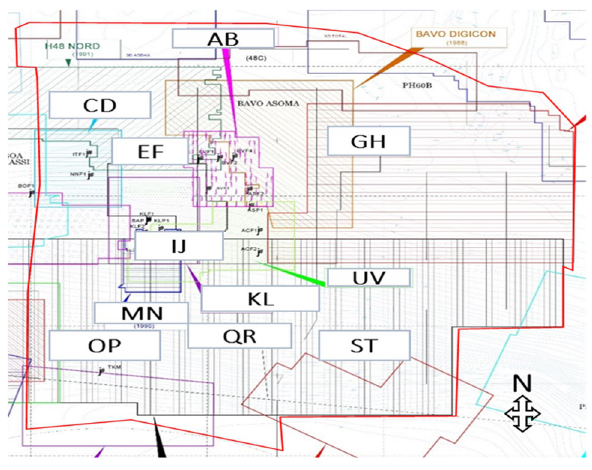
Fig. 4 Hydrocarbon indicators shown as bright spots, dim spot, and flat spot in a reservoir (Løseth et al. 2009 in Tanveer 2012)